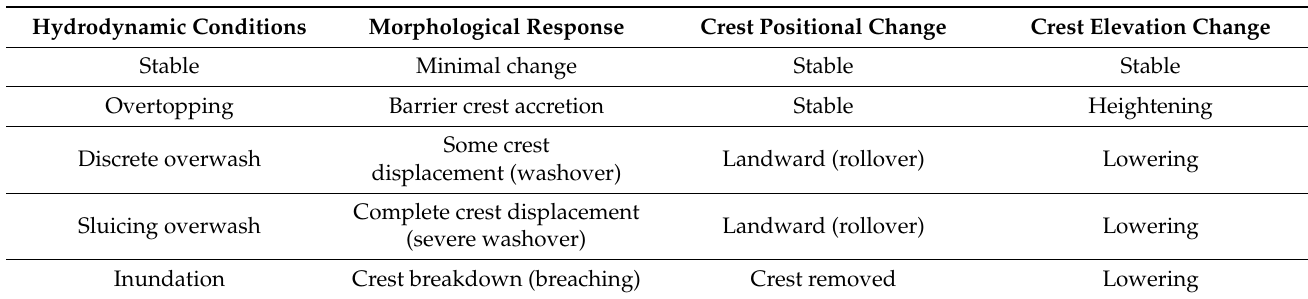
Table 1. Hydrodynamic and associated morphological responses of gravel barriers (based on ref [23]). Hydrodynamic Conditions Morphological